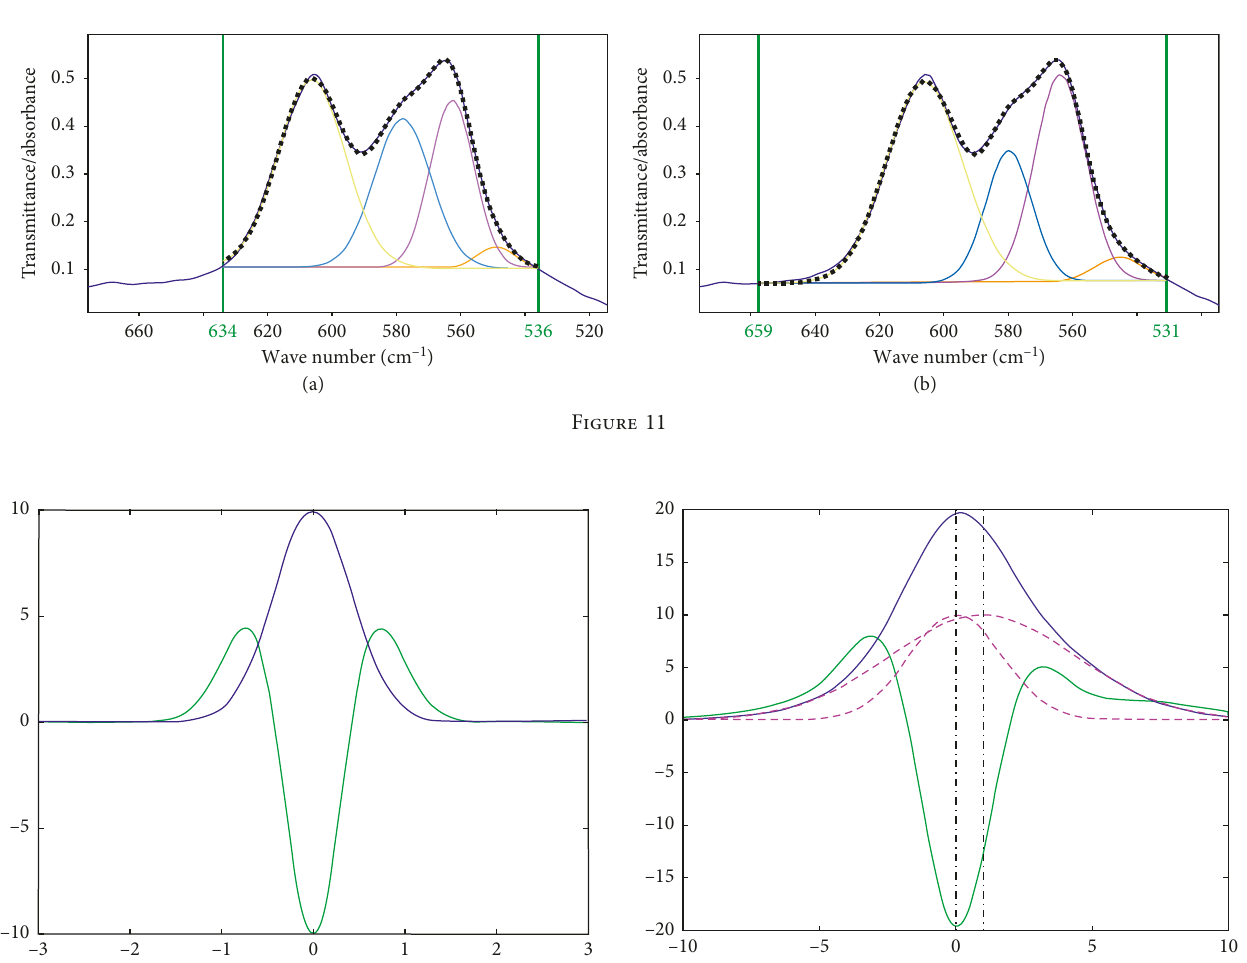
Figure 13: Sum of two Gaussians (blue), its second derivative (green), and the individual peaks (pink). It shows that only one peak is found. The wider peak is hidden in the right part of the second